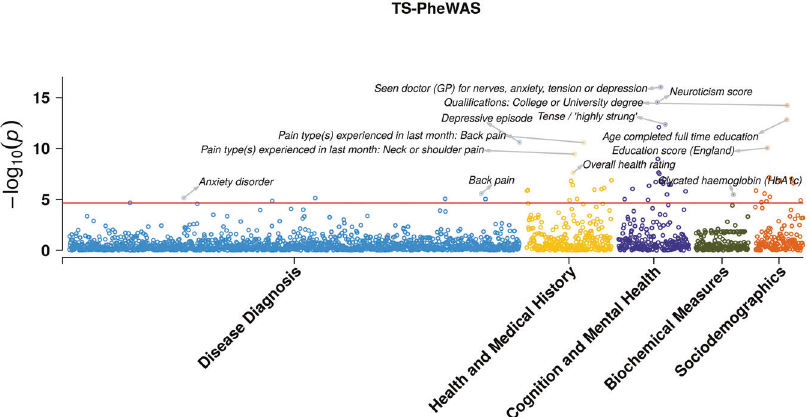
Fig. 2 PheWAS Manhattan plot showing associations of phenotypes with TS PRS, grouped by categories. The horizontal line is marked at the Bonferroni threshold of signi fi cance for multiple testing ( p < 2.23 × 10 − 5 ). The top 3 signi fi cant associations in each category are highlighted and